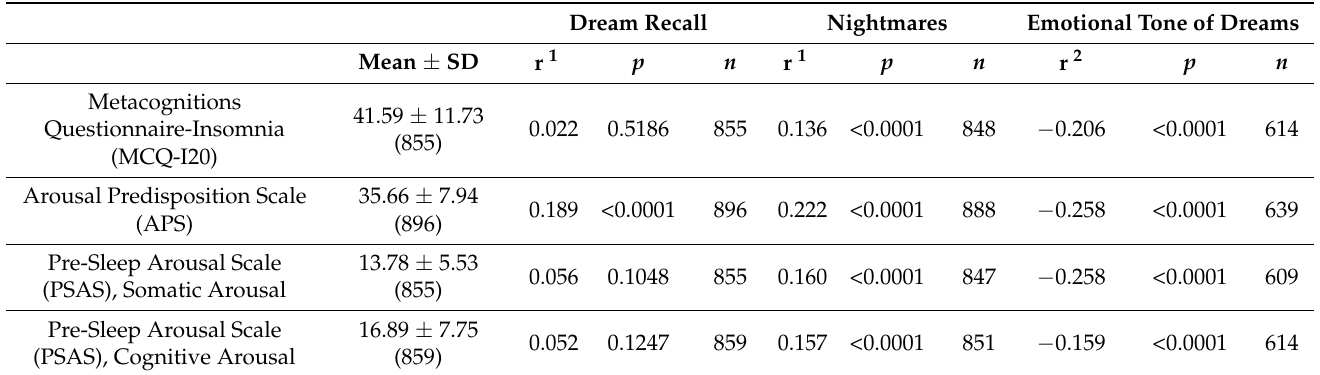
Table 4. Means, standard deviations, and zero-order